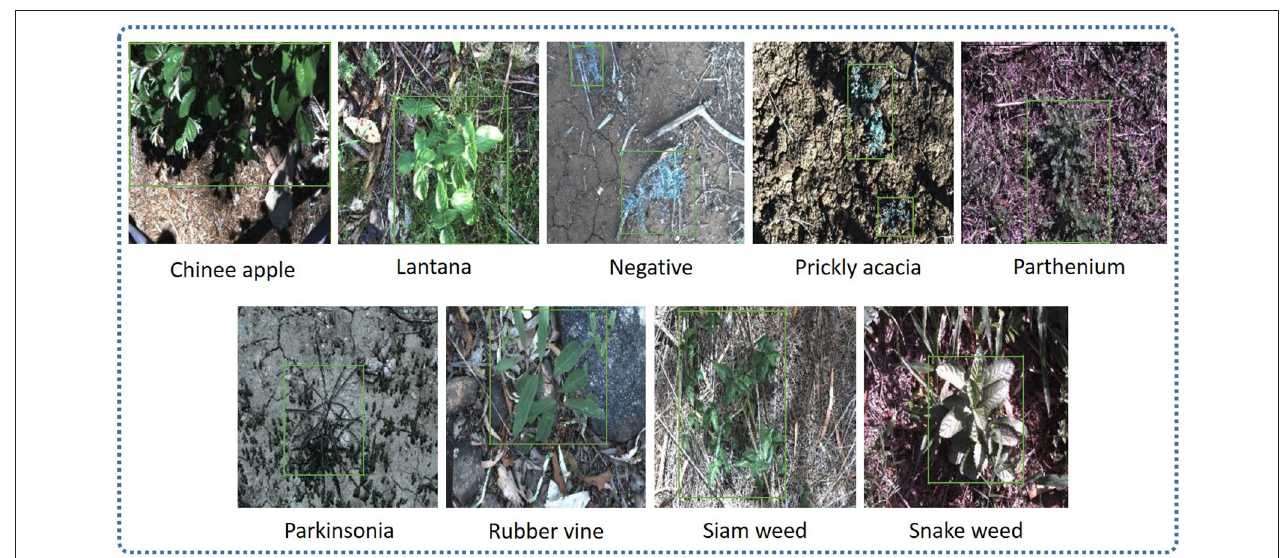
FIGURE 2 | Sample of the annotated dataset for each